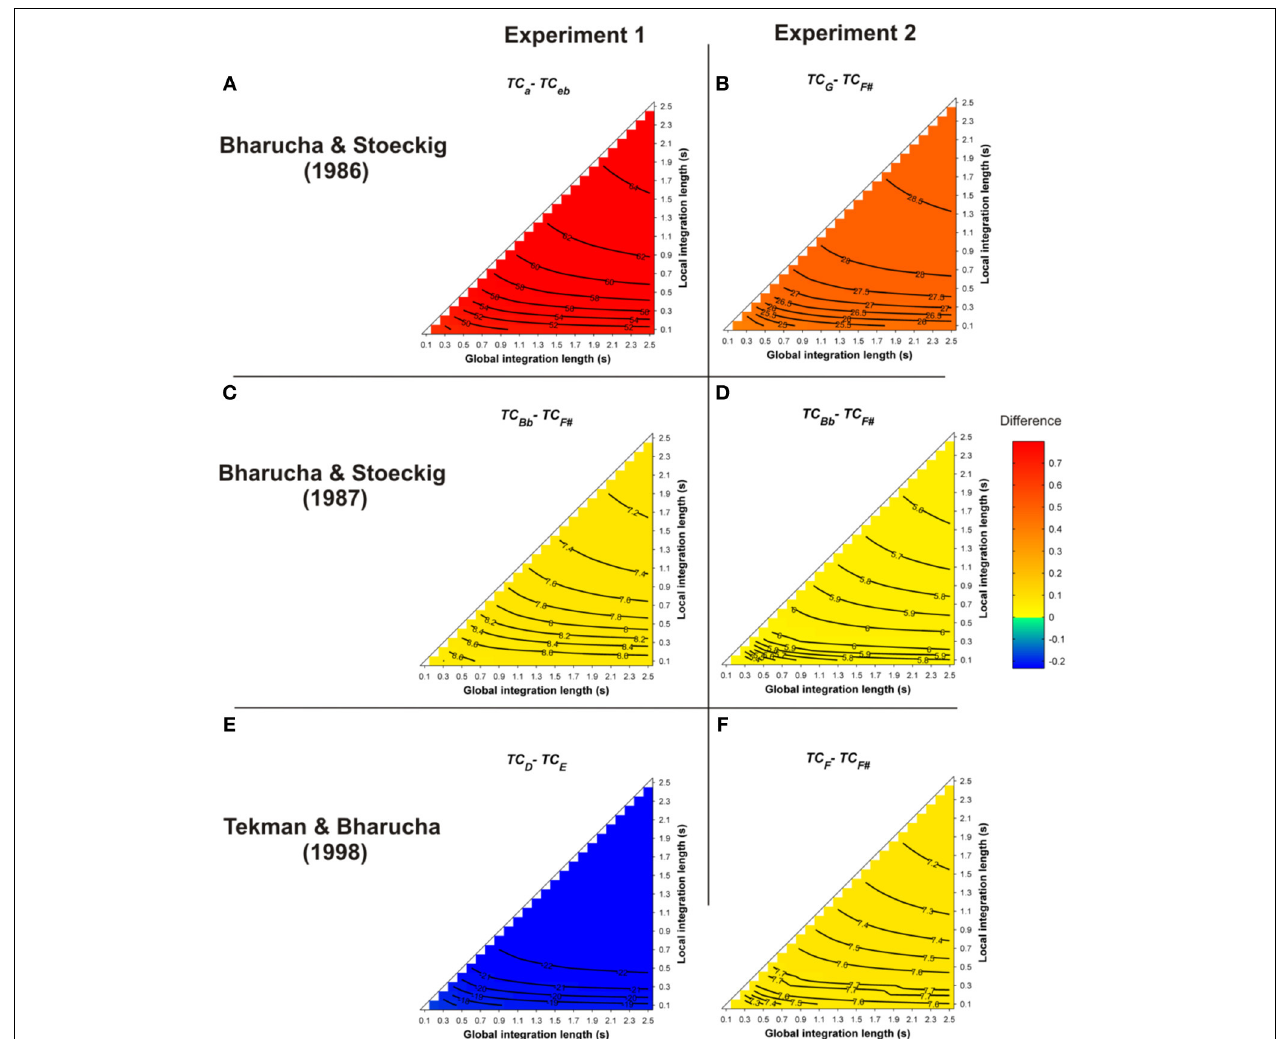
FIGURE 2 | Mean differences between the TC of the target chords ( TC related − TC unrelated ), following a single-prime chord, as a function of the local and global context integration windows. Rows indicate different studies (Panels A,B : Bharucha and Stoeckig, 1986; Panels C,D : Bharucha and Stoeckig, 1987; Panels E,F : Tekman and Bharucha, 1998). Positive, negative, and nonsignificant differences are represented by hot, cold, and white colors, respectively (two-tailed paired t -test, p < 0 . 05; t -values are reported as